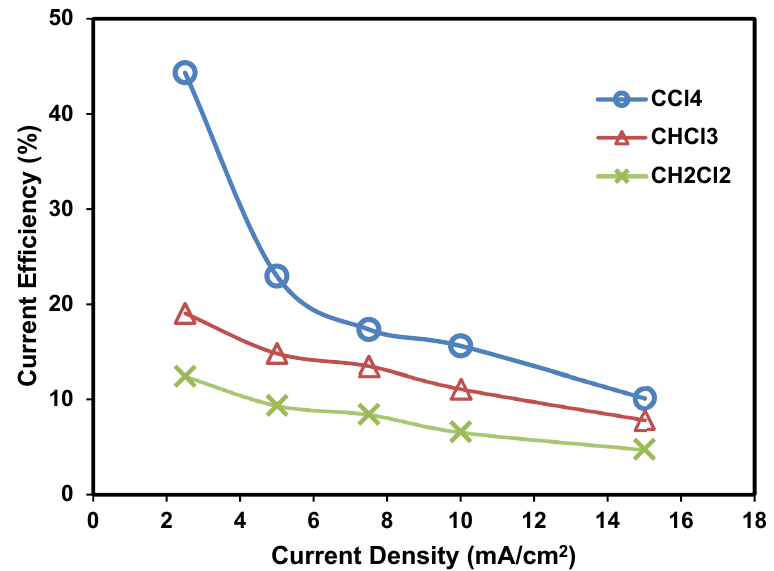
Figure 3. Effect of current density variation on the electrode current efficiency for the organochlorides